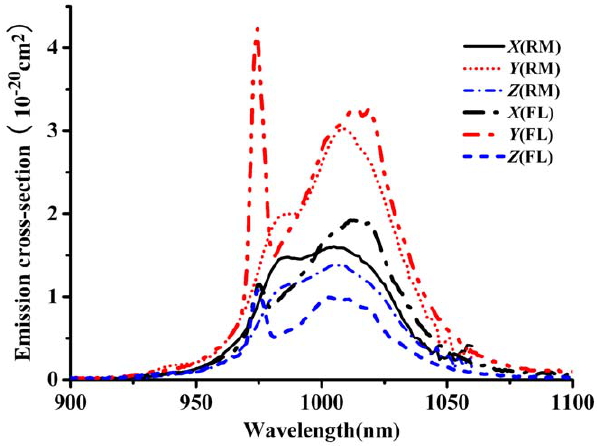
Figure 12. Emission cross-section of Yb 3 + in KBaGd(MoO 4 ) 3 crystal calculated by the RM and F-L methods.